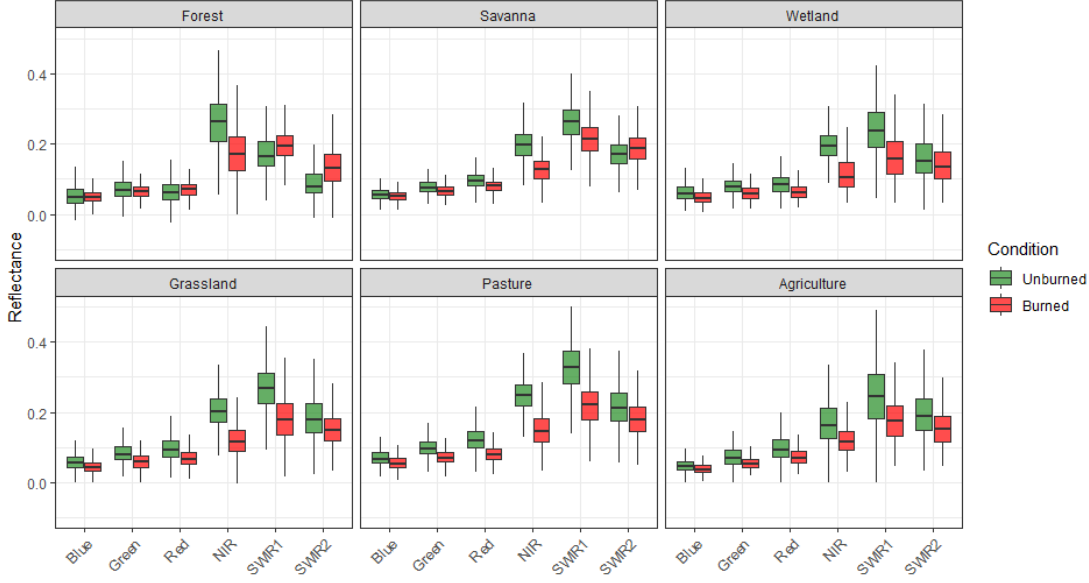
Figure 5. Variation between burned and unburned areas by reflectance bands per land use and cover type. Red boxes (burned) represent the immediately post-fire reflectance values, and green boxes (unburned) represent the reflectance value in a specific year.